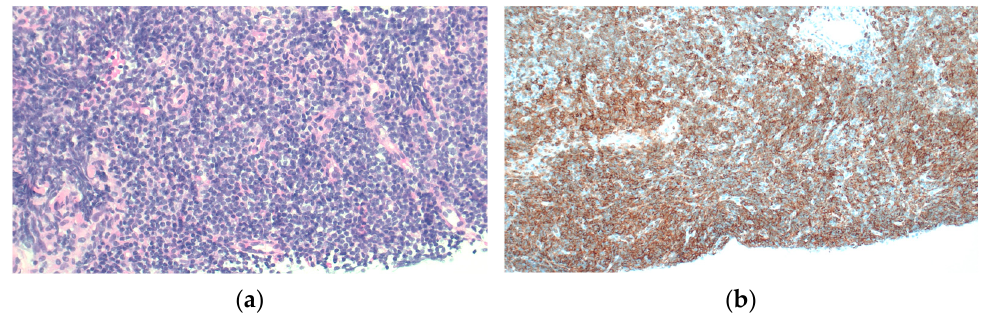
Figure 11. ( a ) Core biopsy of an axillary node in a patient with a grade 1 infiltrating ductal carcinoma in the breast demonstrated chronic lymphocytic lymphoma on H&E ×100, confirmed on immunohistochemistry ( b ) CD 5 ×100. There were insufficient cells on the FNAB for diagnosis.